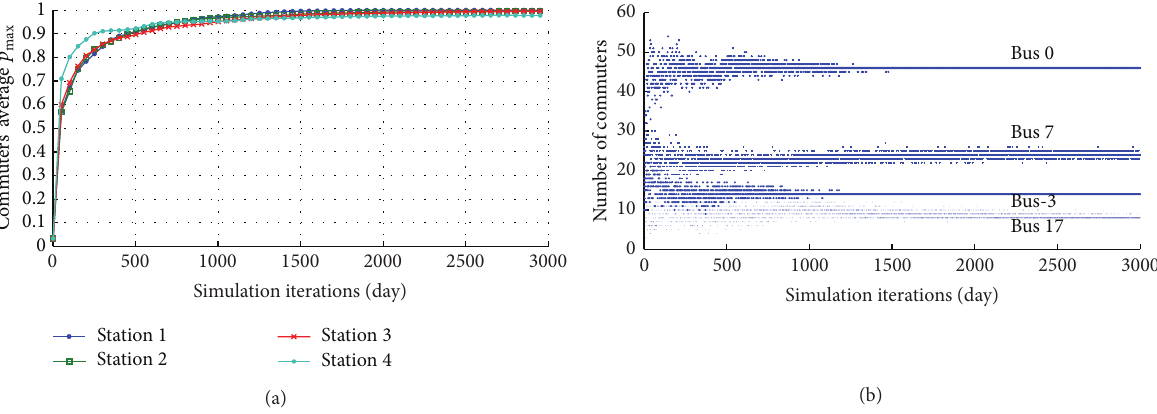
Figure 12: Commuters’ average 𝑝 max and number of commuters on typical buses.